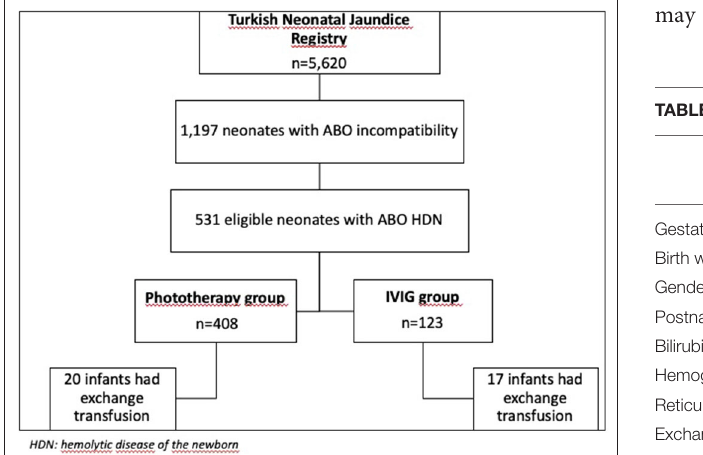
FIGURE 1 | The flowchart of the study.